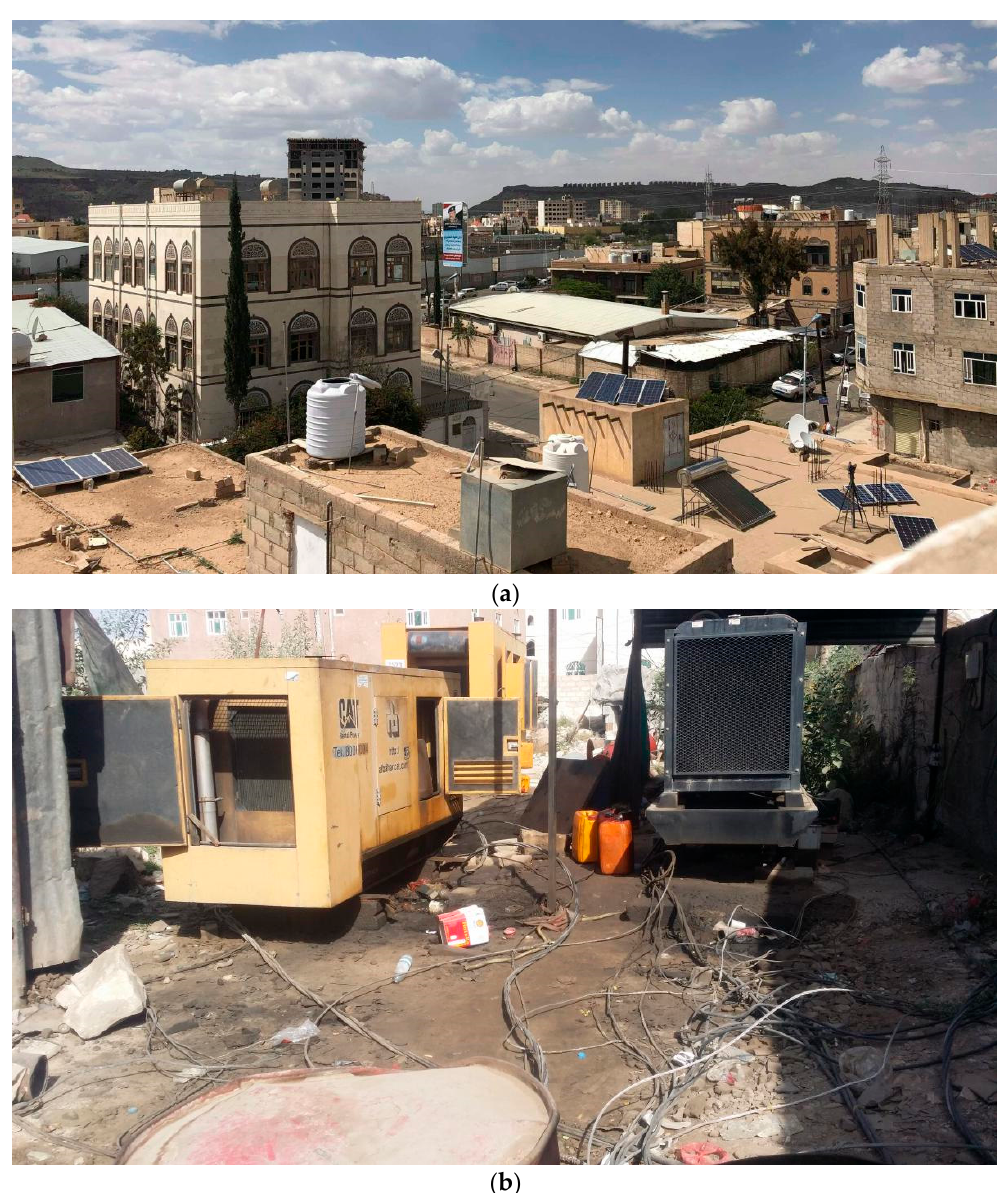
Figure 4. ( a ) Photovoltaic for households’ energy needs: Small rooftop photovoltaic systems widely used by households in the capital city Sana’a. ( b ) Diesel-powered electricity generators at a facility of a private vendor in the capital city of Sana’a (pictures by the authors).